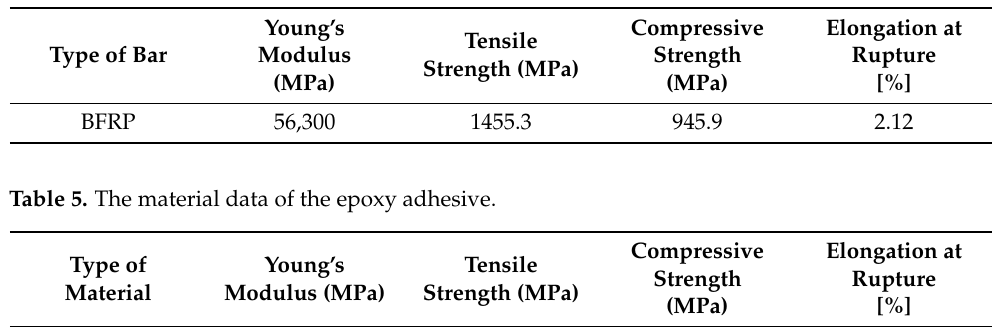
Table 4. The material data of BFRP bars.